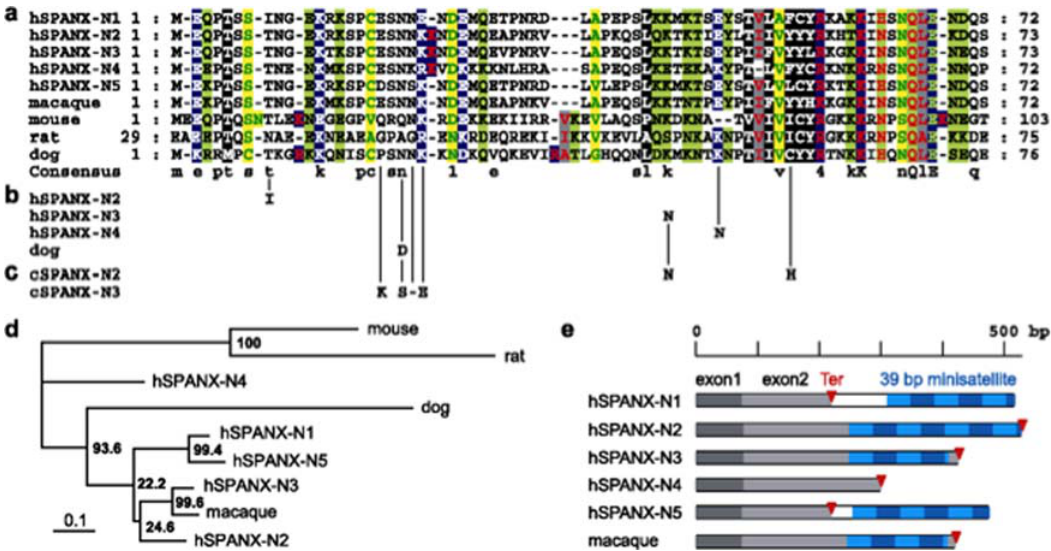
Figure 1. Comparison of mammalian SPANX-N proteins. ( a ) Alignment of the conserved core between human SPANX-N proteins and homologs in non-primate mammals. With the exception of rat SPANX-N, the core starts immediately at the N-terminus. The plot highlights physiochemical properties, and the sequence conservation is shown as a consensus at the bottom. ( b ) Polymorphic positions in the human and dog coding sequences (only core shown). Two nonsynonymous changes, N21D and S79N (not shown), were found in the four dog and two wolf alleles analyzed. The five compared SPANX-N2 alleles revealed a nonsynonymous change, T8I, and a synonymous polymorphism in codons 4, 80, and 151. One amino acid replacement, K43N, was found in the two compared SPANX-N3 alleles. The two analyzed SPANX-N4 alleles revealed only one nonsynonymous change, K48N. ( c ) Substitutions in chimpanzee SPANX-N2 and -N3 coding sequences compared to human homologs. Chimpanzee SPANX-N2 contains four nonsynomous substitutions, two of which are in the core (K43N and Y55H). In addition, there are three synonymous changes and a 65 aa long deletion caused by the deletion of five 39 bp minisatellite units. Chimpanzee SPANX-N3 contains 10 nonsynonymous changes compared to human SPANX-N3, with three in the conserved core (E18K, N21S, and K23E). There is also a single aa deletion, del22K, and two synonymous changes. ( d ) Phylogenetic relationship of SPANX-N proteins in mammals obtained using the maximum likelihood method. ( e ) Minisatellite variations in the C-terminal part of primate SPANX-N genes. With the exception of the human SPANX-N4 locus, the C-terminal regions contain 39 bp minisatellite arrays (blue). In some cases, the translation termination codon (red) is located after the array, and the repeats encode the C-terminal portion of SPANX-N genes.